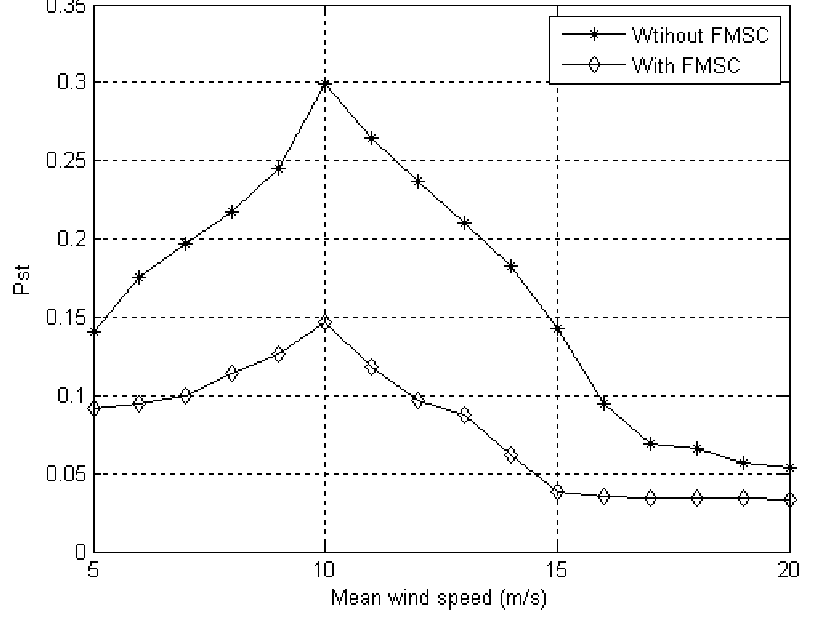
Figure 11. The variation of short-term flicker severity P the case without FMSC (asterisk) and the case with FMC